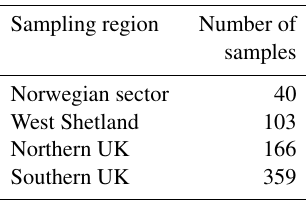
Table A2. Number of whole air samples obtained in each defined region.